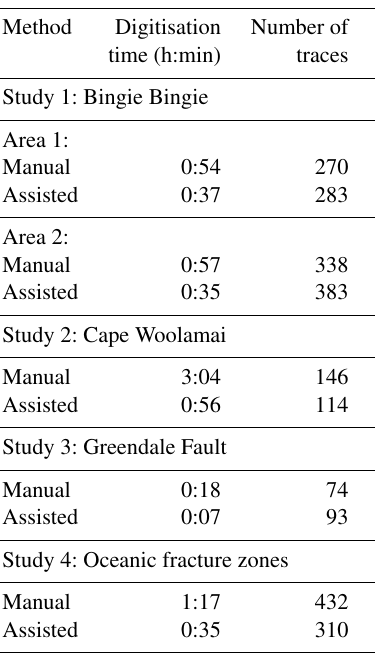
Table 1. Manual vs. computer-assisted digitisation for the different study areas. Percentage improvements are calculated by comparing the average time and mouse clicks per digitised trace. Each case study shows a clear reduction in digitisation time, especially for the 3-D datasets for which manual interpretation can be especially